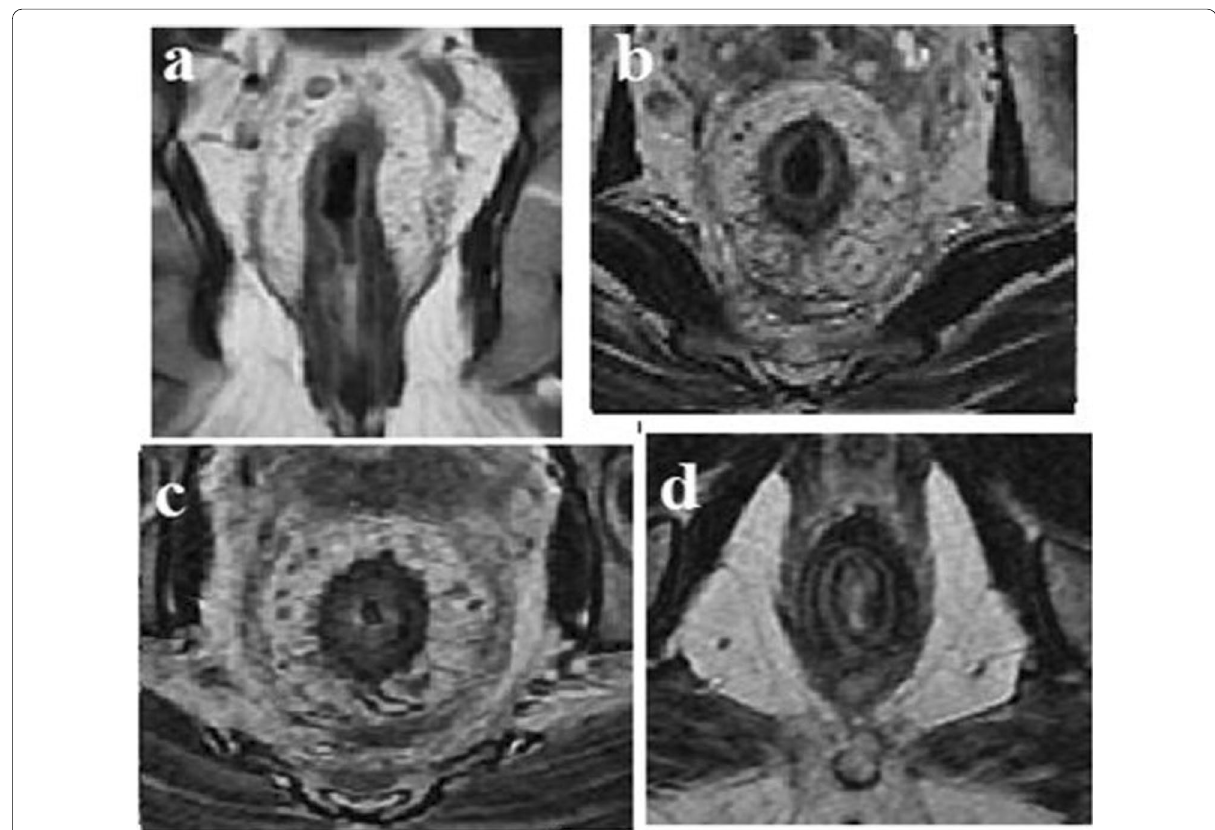
Fig. 1 a–d MRI study for a 39 years old male with anorectal mucinous carcinoma and received CRT. Coronal ( a ) and Axial ( b–d ) T2 WIs, revealed circumferential diffuse hypointense signal of the rectal wall/anal canal with mild submucosal hyperintense T2 signal (interpreted as post-therapy fibrotic changes with mild submucosal edema). Stranding appearance/smudging of the mesorectal fat planes and mildly thickened hypointense mesorectal fascia. Intact external anal sphincters and levator